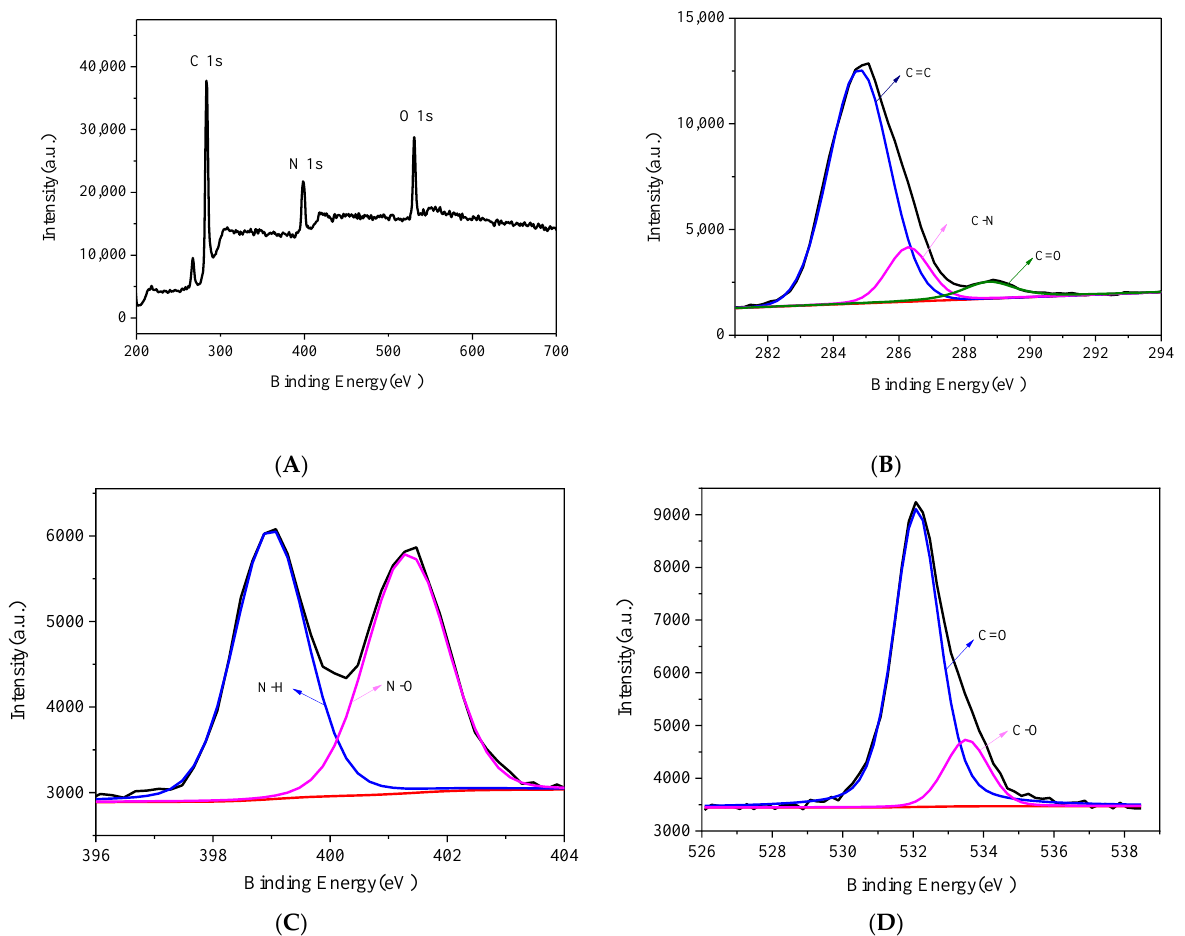
Figure 3. ( A ) XPS spectra of N-CDs, high resolution ( B ) C 1s, ( C ) N 1s, and ( D ) O 1s peaks of N-CDs.